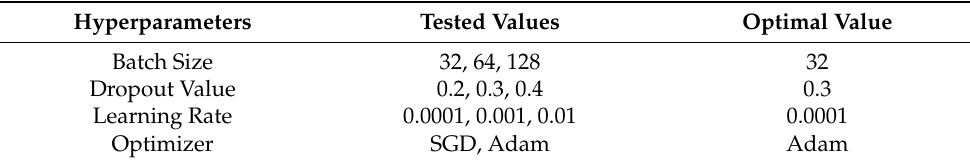
Table 3. Summary of hyperparameter tuning and optimal hyperparameter settings for the proposed VGG16-MLP model.